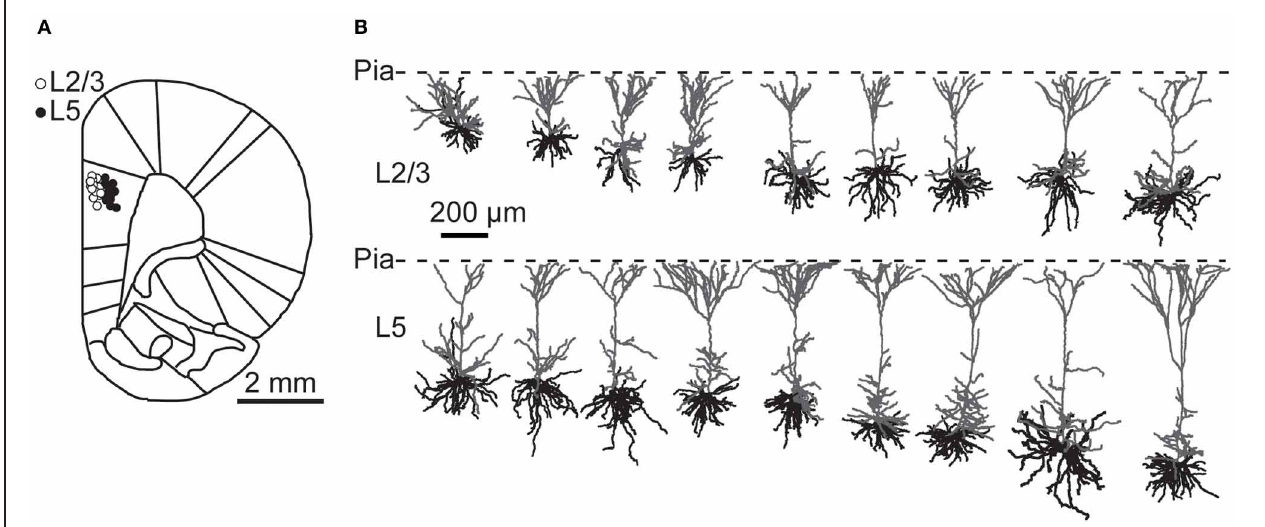
FIGURE 1 | Recording locations and dendritic morphology of prelimbic PFC pyramidal neurons. (A) Cartoon of a coronal section through rat prefrontal cortex with superimposed recording locations of prelimbic PFC